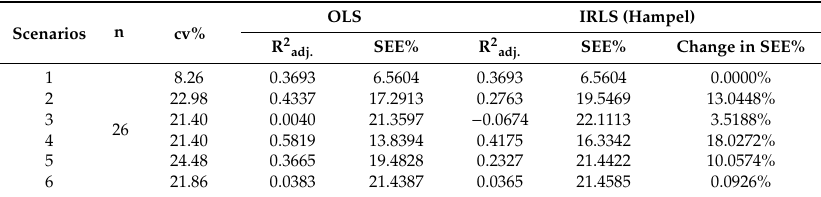
Table 8. Statistics for Henriksen’s model fitted to predict total height in Ochroma pyramidale trees of age